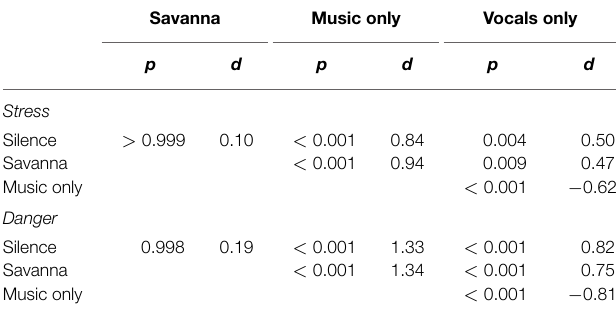
TABLE 1 | Bonferroni-corrected p -values and effect sizes for the differences of stress and danger ratings between the four sound